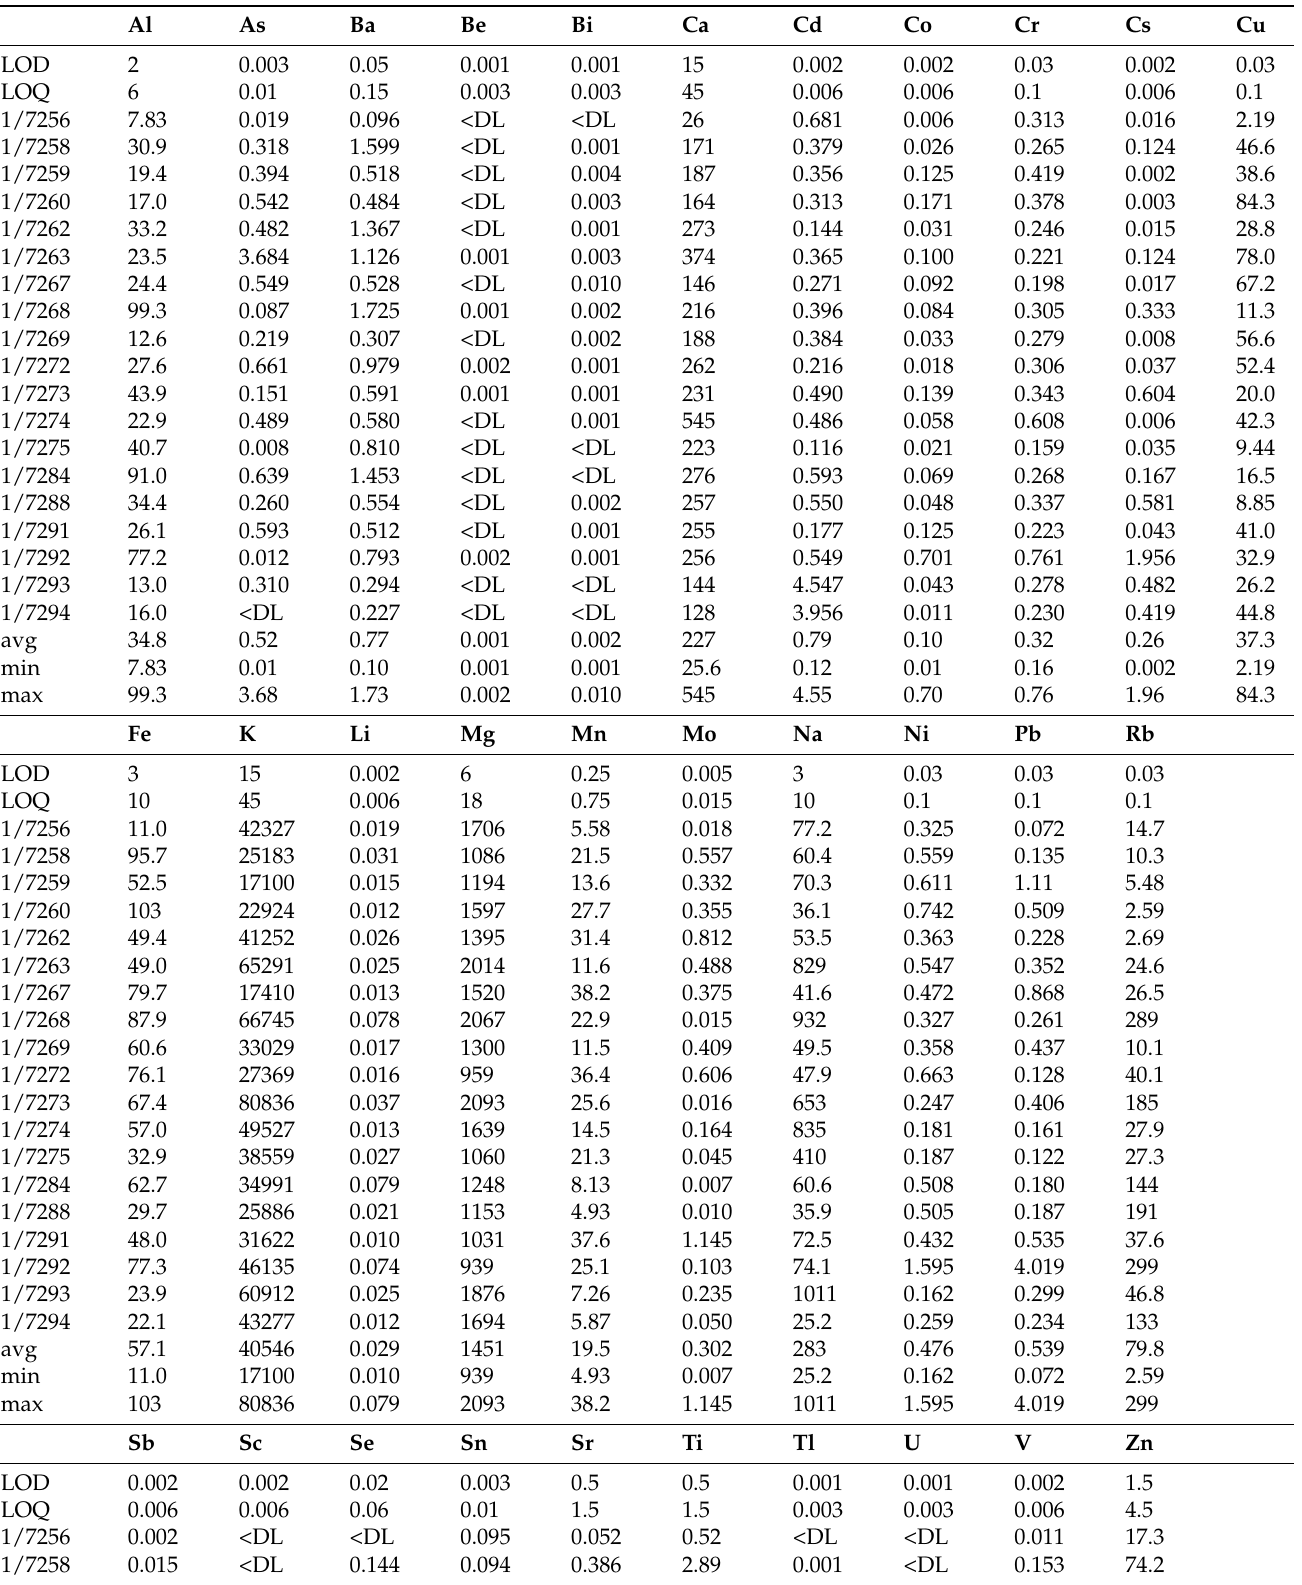
Table 2. Concentrations (in mg kg − 1 , dry matter) of macro- and trace elements in the investigated mushrooms,